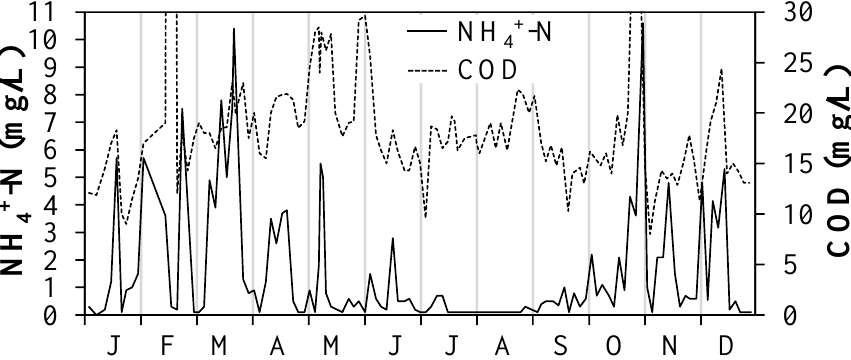
Figure 1. Ammonium ions and chemical oxygen demand (COD) concentrations determined in WWTE of the LFKW (x-axis: months).